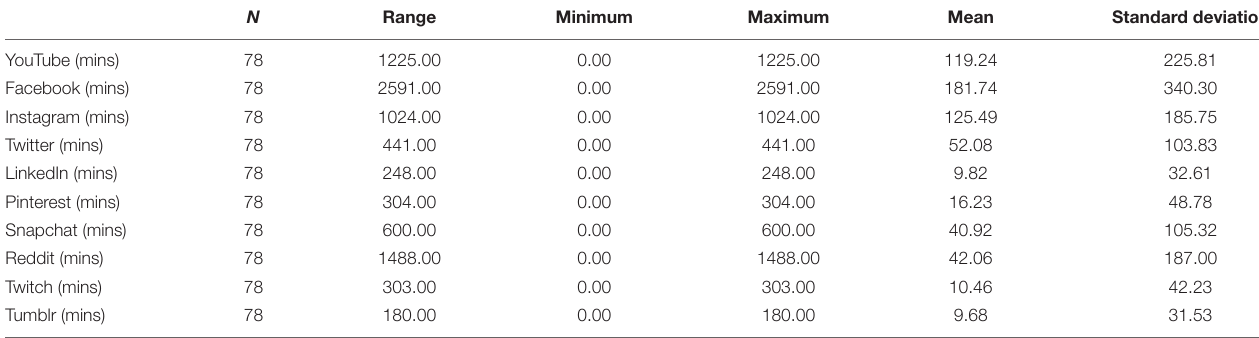
TABLE 6 | Descriptive statistics for duration of social media